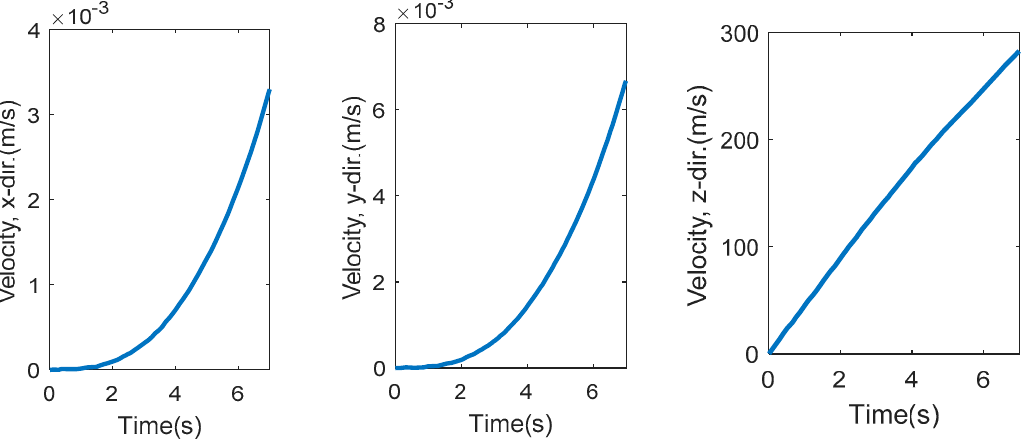
Figure 12. Variations in linear velocity in the robustness scenario.